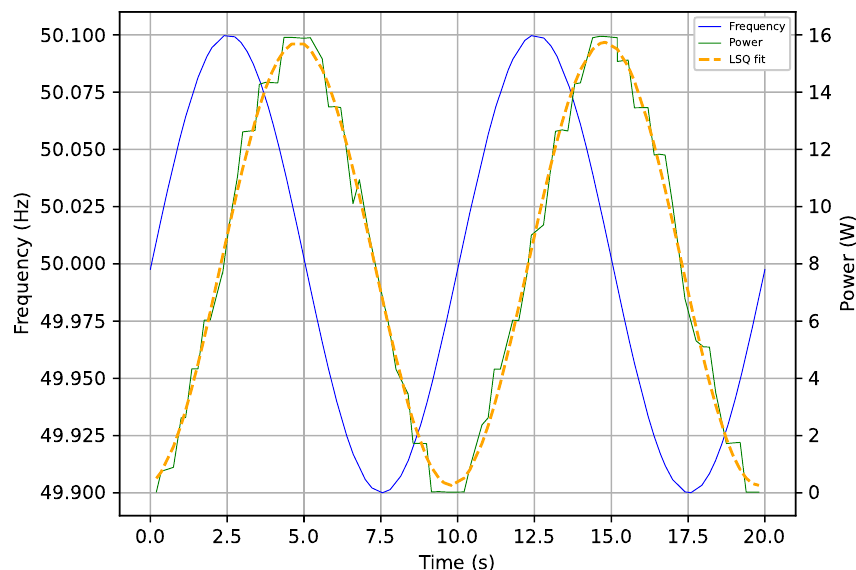
Figure 2. An example least-squares fit (orange curve) to reserve active power measurements (green curve). The blue curve is the sinusoidal input signal.